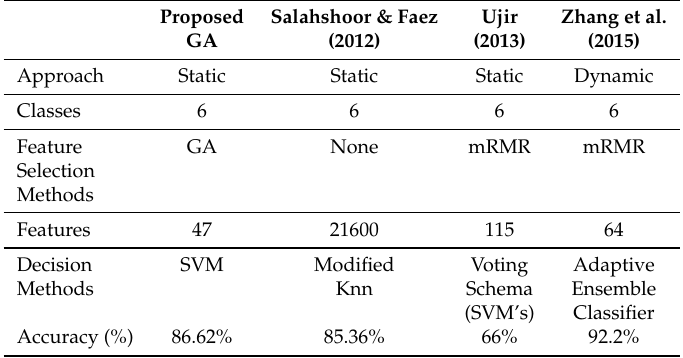
Table 18. Comparison on Bosphorus Dataset with handcrafted